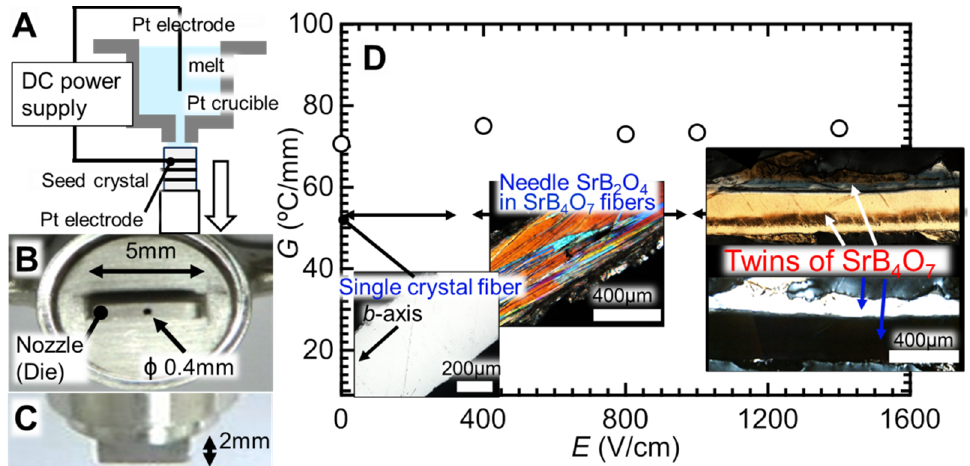
Figure 1. Growth by the micro-pulling-down method with applying electric fields. ( A ) Schematic drawing of the setup; ( B ) bottom of the Pt crucible; ( C ) side view of the Pt crucible; ( D ) growth condition (open circles) of this study. A white arrow corresponds to the pulling-down direction ( c -axis). Seed crystals were fixed to the alumina rod by Pt wire. The other Pt wire was immersed into melt of SBO. The photographs in ( D ) show the summary of our previous study [23], and these correspond to the growth along the b -axis. At E ≧ 400 V/cm needles of SrB 2 O 4 appeared inside SBO fibers, and at E ≧ 1000 V/cm growth twins of {100} faces were formed perpendicular to growth fronts. Figure 1 reprinted with permission from Sho Inaba, Ryouta Ishibashi, Harutoshi Asakawa, Takaaki Machida, Yuki Hamada, and Ryuichi Komatsu, Effects of the Application of Electric Fields on the Growth of SrB 4 O 7 Crystals by the Micro-Pulling-Down Method, Cryst. Growth Des. 2021,